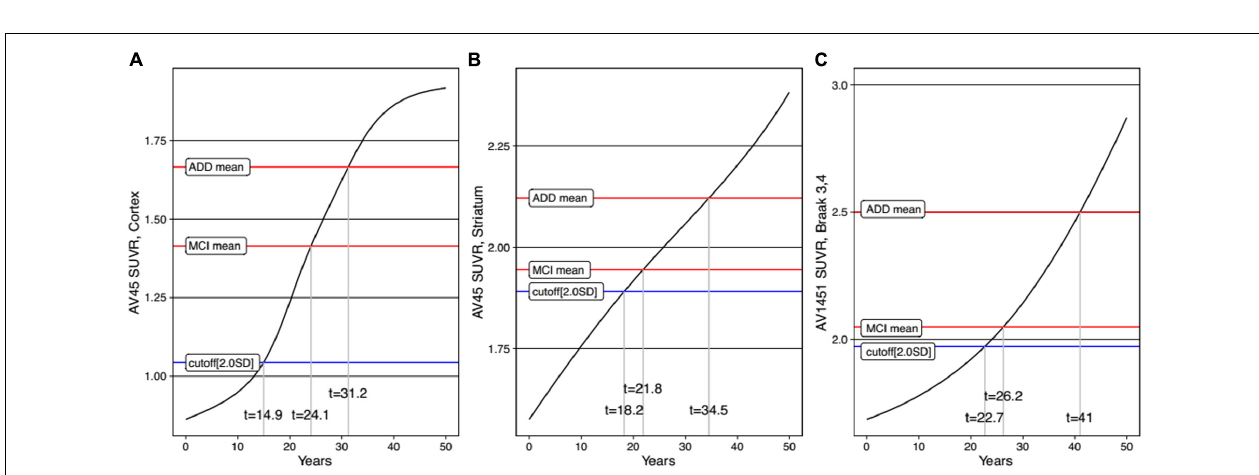
FIGURE 3 | Rates of change (worsening) as a function of SUVRs in cortical amyloid (A) , striatal amyloid (B) , and pathological tau (C) . AV45, 18 F-florbetapir; SUVR, standardized uptake value ratio; AV1451, 18 F-flortaucipir.